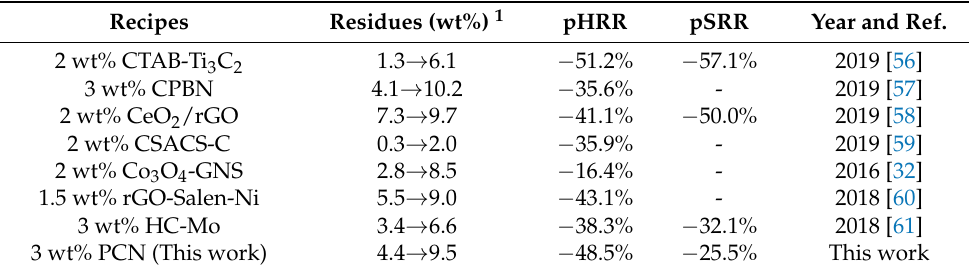
Table 6. Thermal and burning parameters of TPU flame-retardant composites reported in previous work and this work.